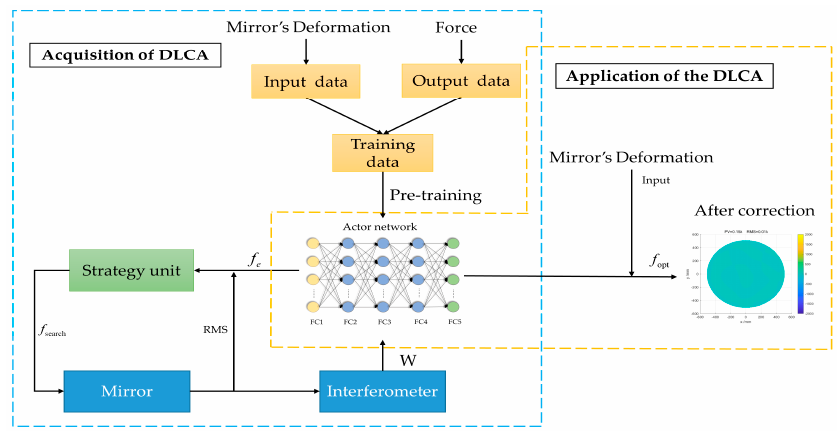
Figure 5. The working procedure of the DLCA.